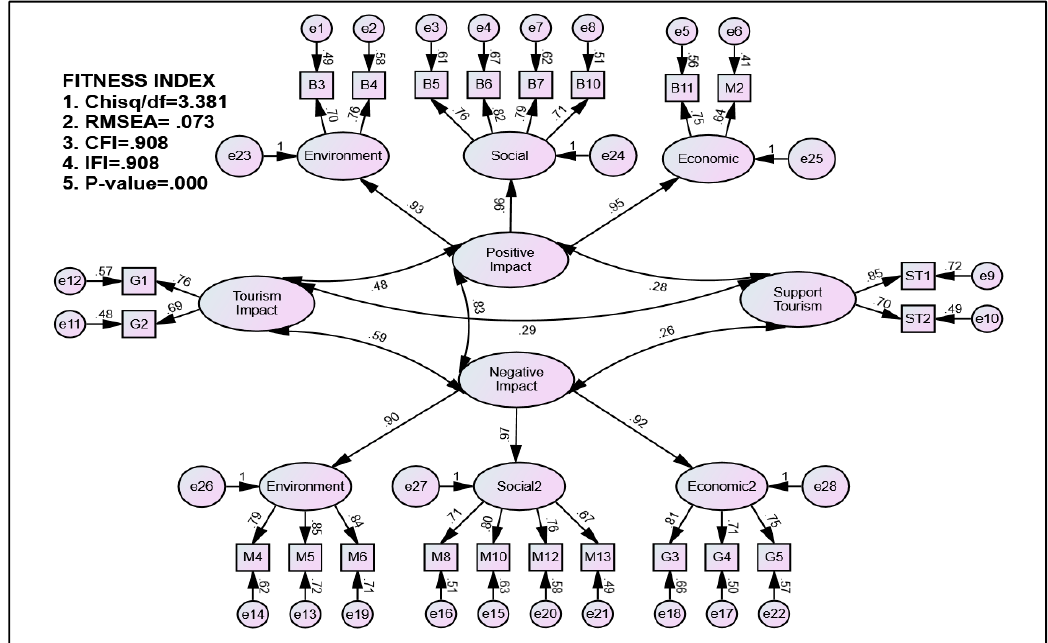
Figure 2. Confirmatory Factor Analysis (CFA).